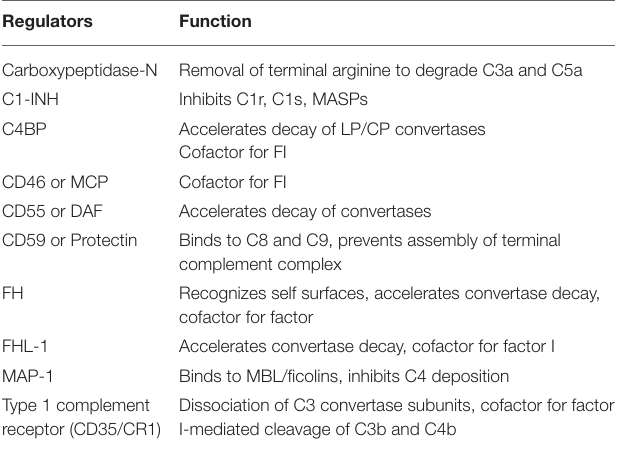
TABLE 2 | Regulatory targets of the complement